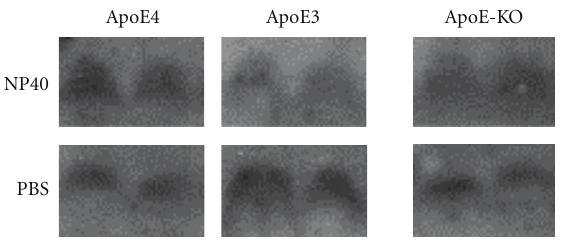
Figure 3: A β 42 immunoblot of the hippocampal CA1 field of apoE4, apoE3, and apoE-deficient mice. The mice were treated for 10 days with thiorphan after which they were killed and their hippocampus was extracted and immunoblotted with the anti- A β 42 Ab 266 as described in “Materials and Methods.” Membrane bound NP40 extractable A β 42 (apparent molecular weight 4.5kD) is shown in the upper panels whereas the corresponding PBS extractable soluble A β 42 is shown in the lower